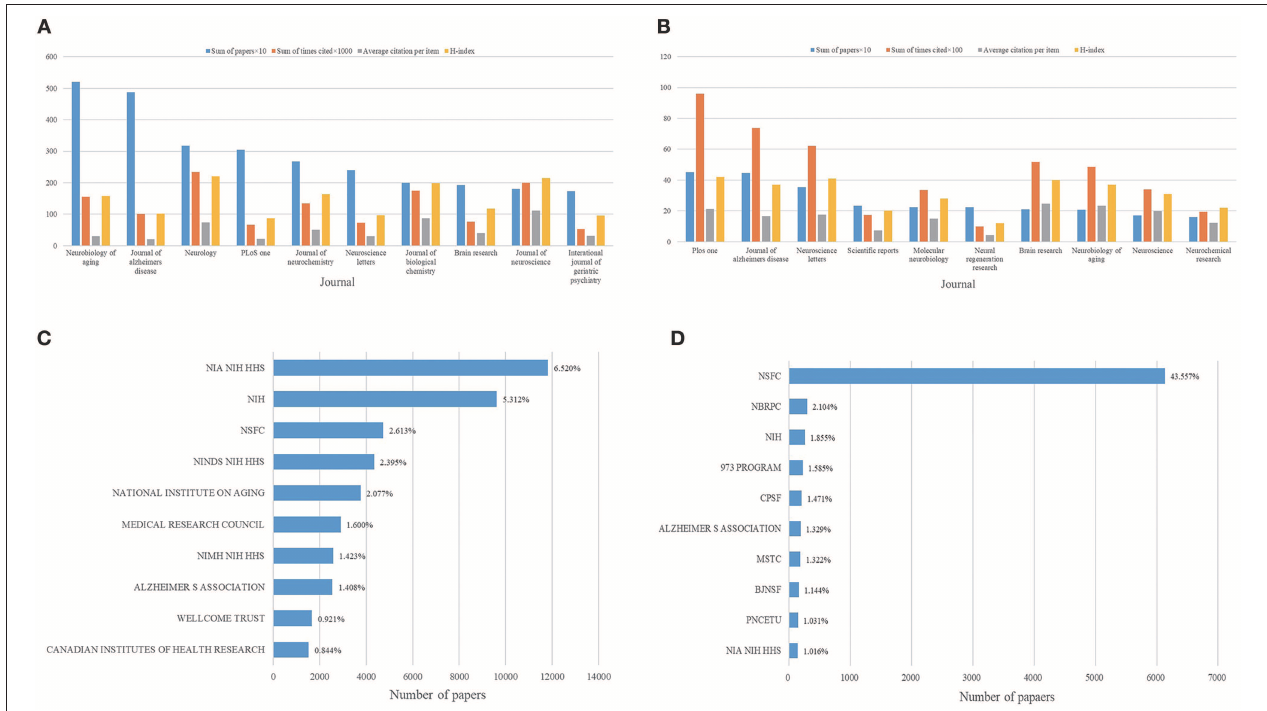
FIGURE 7 | Highly contributing journals and funding systems to AD research publications globally and in China. (A) Sum of publications, total citations, average citations per article, and h-index for AD research journals worldwide. (B) Sum of publications, total citations, average citations per article, and h-index for AD research journals in China. (C) Top 10 funding systems contributing to global AD research. (D) Top 10 funding systems contributing to AD research in China. NIA, National Institute on Aging; NIH, National Institutes of Health; NSFC, National Natural Science Foundation of China; NINDS, National Institute of Neurological Disease and Stroke; HHS, Department of Health and Human Services; NIMH, National Institute of Mental Health; NBRPC, National Basic Research Program of China; 973 PROGRA, National High Technology Research and Development Program of China; CPSF, China Postdoctoral Science Foundation; MSTC, Ministry of Science